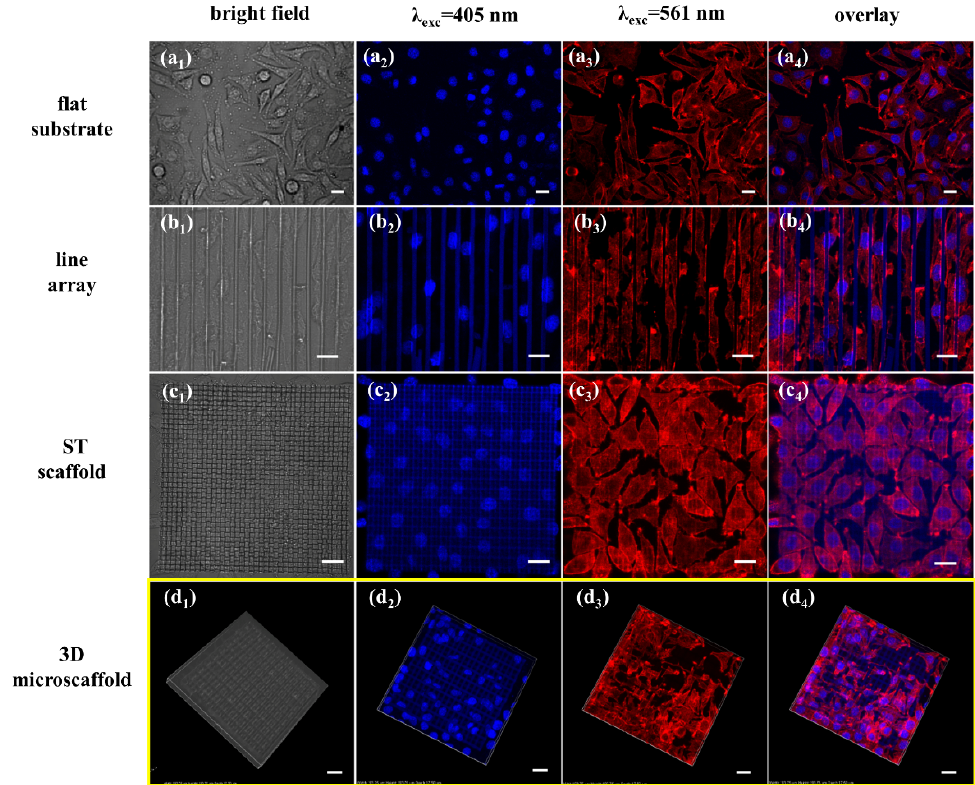
Figure 5. Bright field images, fluorescence images (excited by 405 nm and 561 nm) and overlay images of the cells on different microstructures. The overlay image was obtained from the fluorescence images of nuclei and F-actin. ( a 1 – a 4 ) Images on the flat substrate. ( b 1 – b 4 ) Images on the patterned substrate with line array. ( c 1 – c 4 ) Images on the ST scaffold with small pore size and thin strut. ( d 1 – d 4 ) Images on the 3D microscaffold with strut spacing of 20 μ m. The scale bar is 20 μ m.